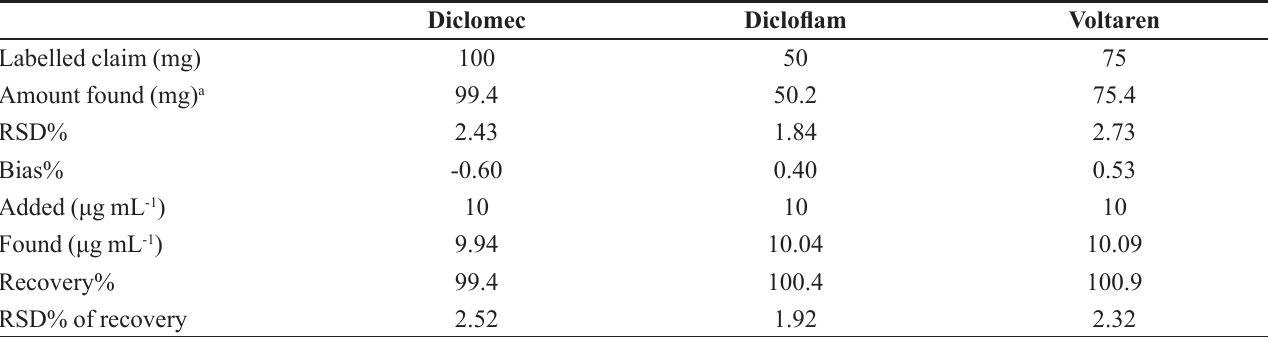
TABLE II - Recovery of the diclofenac in pharmaceutical preparations Diclomec Dicloflam Labelled claim